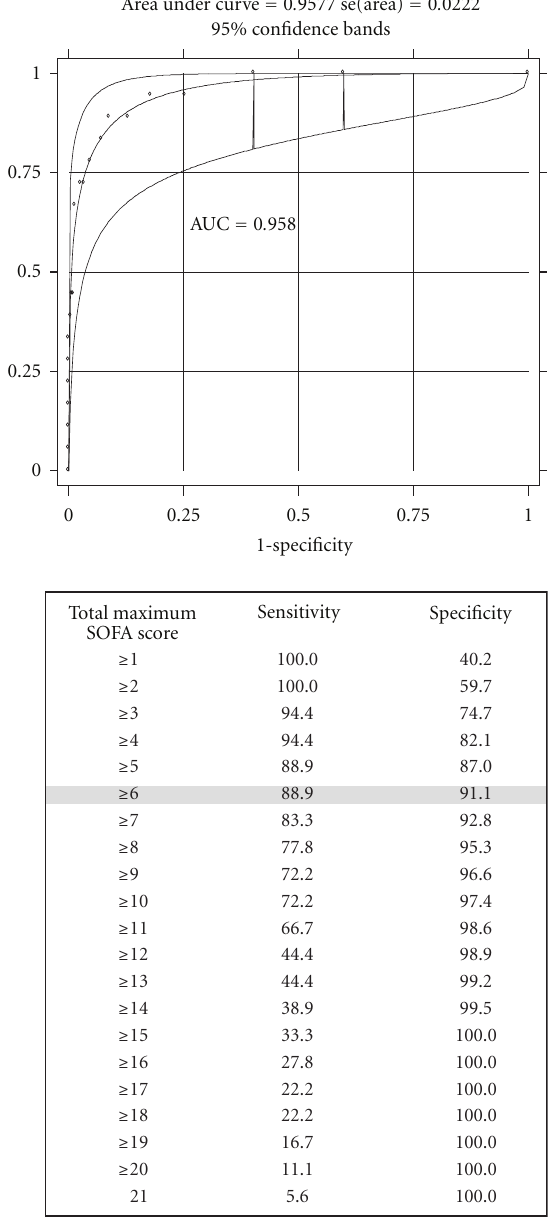
Figure 3: The area under the receiver operating characteristic (ROC) curve for total maximum SOFA (Sequential Organ Failure Assessment) score with di ff erent cuto ff points as predictors of death among cases of severe maternal